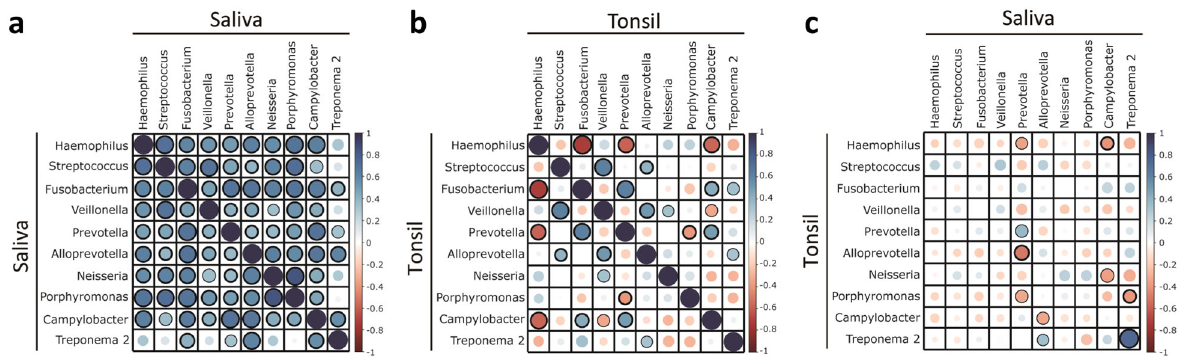
Fig. 4 Correlation of the top 10 ranked microbes. Correlation plots of the top 10 ranked microbes a within the saliva, b within tonsils, and c between saliva and tonsils. A correlation matrix plot (based on Spearman ’ s correlation) is presented. Positive and negative correlations are represented by blue or red circles, respectively, and the size and color of circles refer to the correlation value. Signi fi cant correlations are indicated by the black outline of the circle with p ≤ 0.05 (thick border) and p ≤ 0.1 (thin